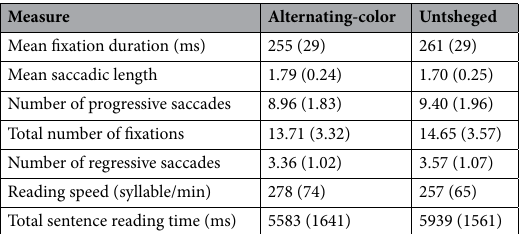
Table 4. Means (and standard deviations) of eye movement measures based on global analysis.